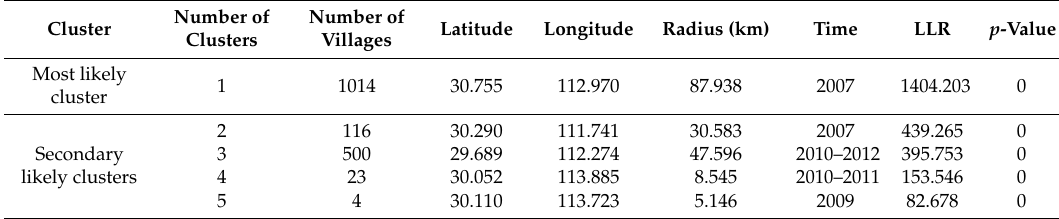
Table 2. Space–time analysis of clusters with large populations of schistosomiasis infections using Kulldorff’s spatial scan statistic.